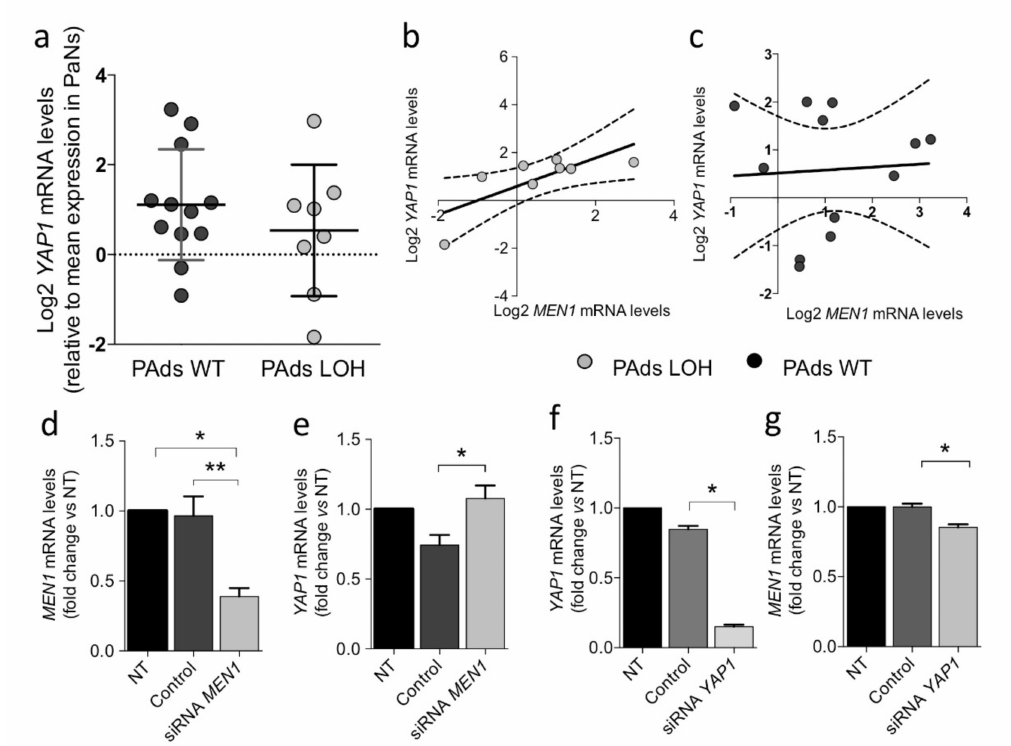
Figure 2. YAP1 expression and chromosome 11 status in parathyroid adenomas. ( a ) YAP1 gene expression levels in parathy- roid adenomas (Pads) with a normal haplotype for chromosome 11 (PAds WT) or PAds harboring loss of heterozygosity of the chromosome 11 (PAds LOH); YAP1 mRNA levels were relatively quantified on that detected in three normal parathyroid glands and log2-transformed. ( b ) Correlation between YAP1 and MEN1 gene expression levels in PAds harboring the chr.11 LOH (r 2 = 0.561, p = 0.032), and ( c ) in PAds with no loss of chr.11 (WT). ( d ) Transient downregulation of MEN1 by siRNA in PAds-derived cells ( n = 4) was verified by qPCR relative to cultures treated with a mock siRNA (Control) or left untreated (NT); * p = 0.006; ** p = 0.011 by one-way ANOVA. ( e ) YAP1 mRNA expression was analyzed by qPCR after transient transfection with a MEN1 or a control siRNA in primary PAd cultures and expressed relative to untreated (NT) samples; * p = 0.036 by one-way ANOVA. ( f ) Transient downregulation of the YAP1 or a control transcript by siRNA in HEK293A cells ( n = 3) was verified by qPCR relative to untreated samples (NT); *, p = 0.008 by one-way ANOVA. ( g ) MEN1 expression was analyzed by qPCR in HEK293A cultures after transient transfection with a YAP1 or a control siRNA ( n = 3) and expressed relative to untreated samples (NT); * p = 0.021 by one-way ANOVA.